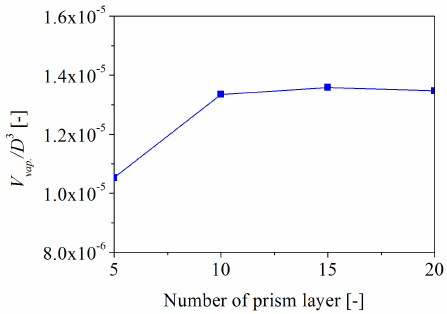
Figure 6. E ff ect of prism layer on vapor Figure 6. Effect of prism layer on vapor volume.